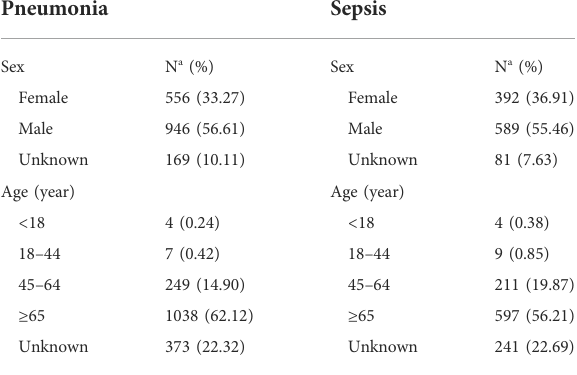
TABLE 2 Clinical characteristics of deaths due to immunomodulatory drugs(IMiDs)related pneumoniaandsepsis intheFAERS database (January 2013 to December